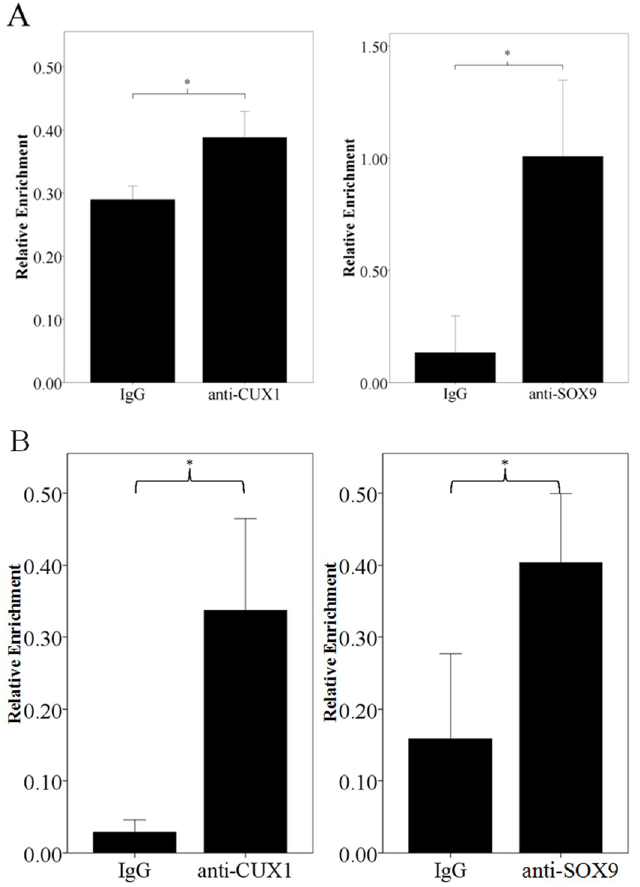
Fig 6. Chromatin enrichment of the region containing position rs66651343 and rs12909095 in Beas-2B (A) or A549 (B) cell. For each part, the left chart is for rs66651343 while the right one for rs12909095. The y axis represents relative enrichment. The result is normalized by input, and the data is presented as mean ± SD. * represents P < 0.05.